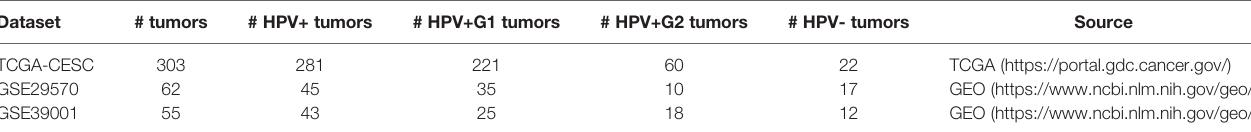
TABLE 1 | A summary of the datasets